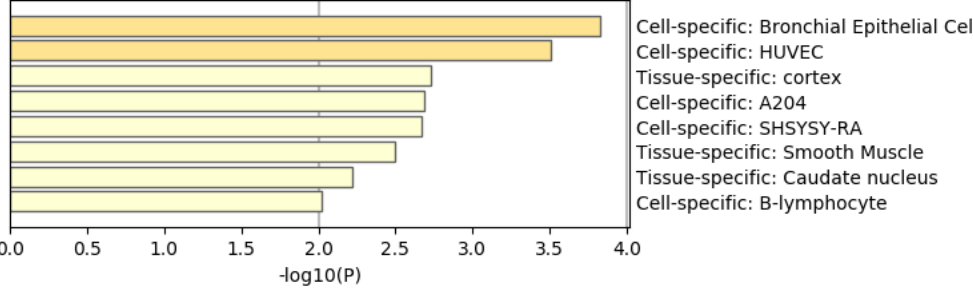
Figure 13. Summary of enrichment of the PaGenBase category of Metascape when 1267 protein-coding genes included in 1447 genomic regions selected by RF are considered.